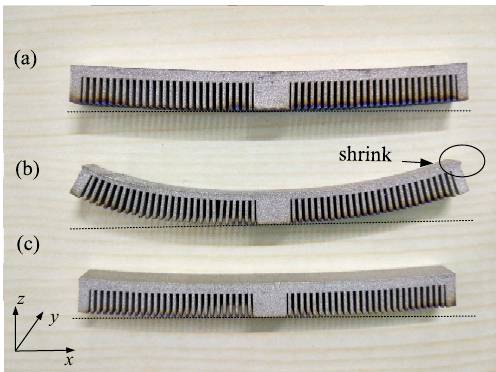
Figure 4. Deformation of the specimens with different scanning routes after being cut from the baseplate: ( a ) scanning along the y direction (transverse scanning); ( b ) scanning along the x direction (longitudinal scanning); and, ( c ) alternative Scanning along x and y direction in consecutive